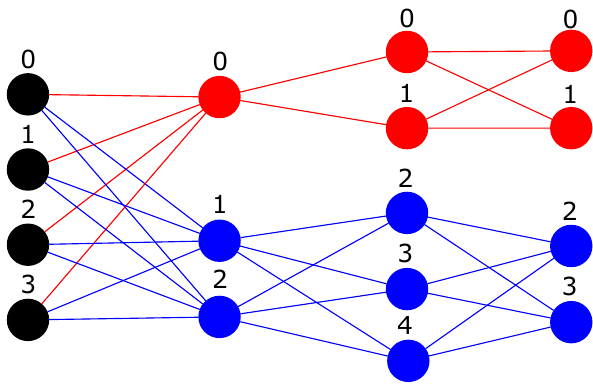
Figure 3. Two independent two hidden layers MLPs represented as a single MLP by ParallelMLP. The first with architecture in red being 4 − 1 − 2 − 2 and the second in blue 4 − 2 − 3 − 2. The weight matrices were removed to ease the readability of the